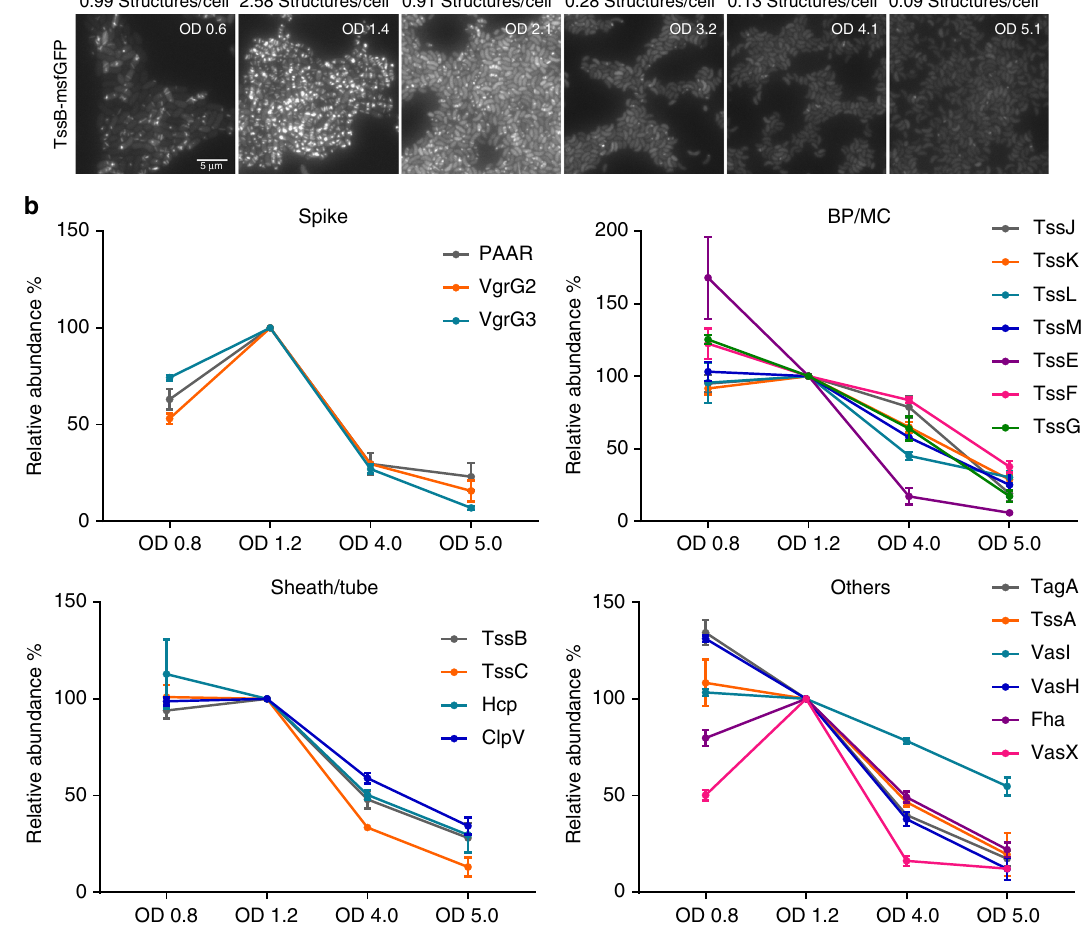
Fig. 3 Change in abundance of V . cholerae T6SS proteins during growth phases. a The sheath assembly was monitored by TssB-msfGFP localization during different growth phases. Representative images of GFP channel are shown. Time-lapse movies with a larger fi eld of view can be found in Supplementary Movie 1. The average number of sheaths is indicated above the images. Scale bar: 5 µ m. b The relative abundance levels of each component during four growth phases (OD 600 ~0.7, ~1.2, ~4, and ~5, respectively). Note the y ‐ axis is shown as % abundance related to the protein levels at T2 (OD 600 ~1.2). The error bar represents the standard deviation of measurements ( n = 3 biologically independent samples). Plots were grouped into four subsets: spike proteins, baseplate/membrane complex, sheath/tube proteins, and other components. Individual plots are shown in Supplementary Fig. 2. The detailed quanti fi cation for this fi gure can be found in Supplementary Data 2. Source data are provided as a Source Data fi